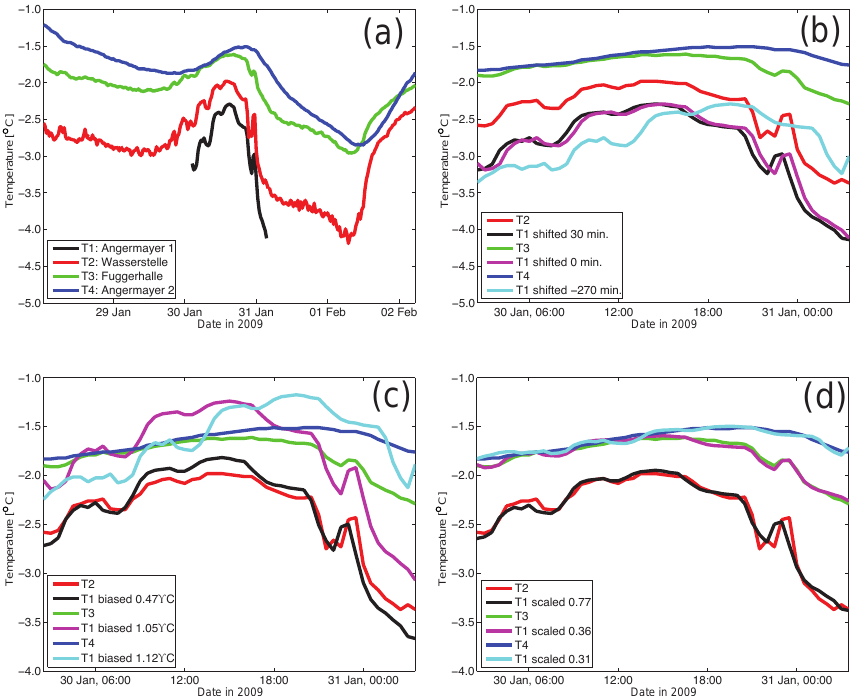
Figure 7. In this example the raw data (a) of logger T1 were shifted (b) relative to loggers T2, T3, or T4 until best correlation was reached. Then (c) temperature biases were applied at logger T1 to fit either T2, T3, or T4 before finally, (d) the temperature variations at logger T1 were scaled to fit loggers T2, T3, or